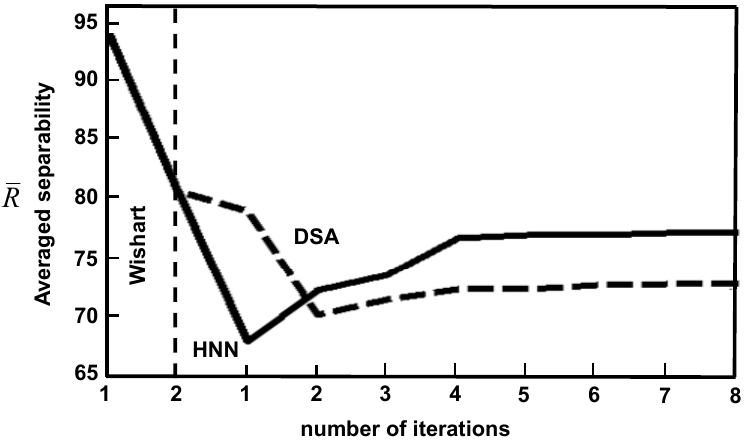
Figure 2. Averaged separability values for the first two iterations of the Wishart classifier and the best performance achieved with HNN and DSA during the four iterations according to